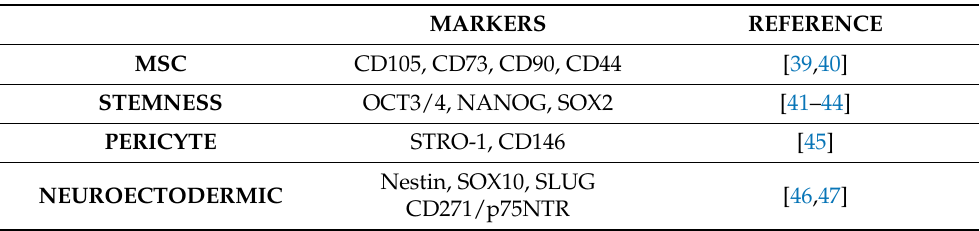
Table 1. Main markers expressed by